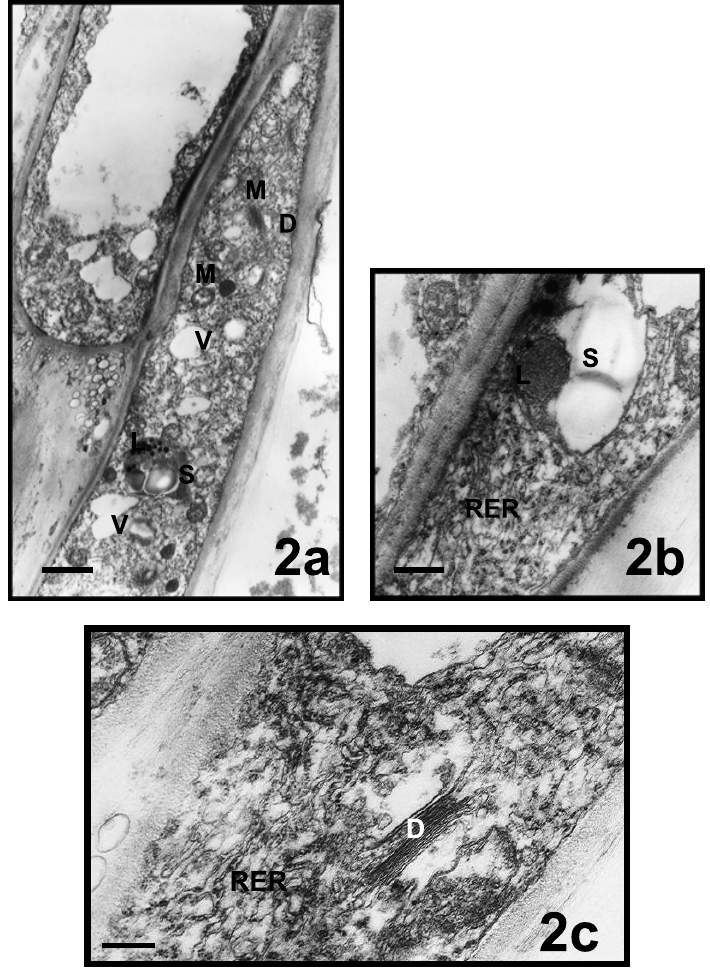
Fig. 2 – Subapical zones of pollen tubes in Mimulus aurantiacus . a, bar = 1 , 5 μ m; b, bar = 0 , 5 μ m; c, bar = 0 , 2 μ m; (D, dictyosome; L, lipid; M, mitochondria; RER, rough endoplasmic reticulum; S, starch; V,